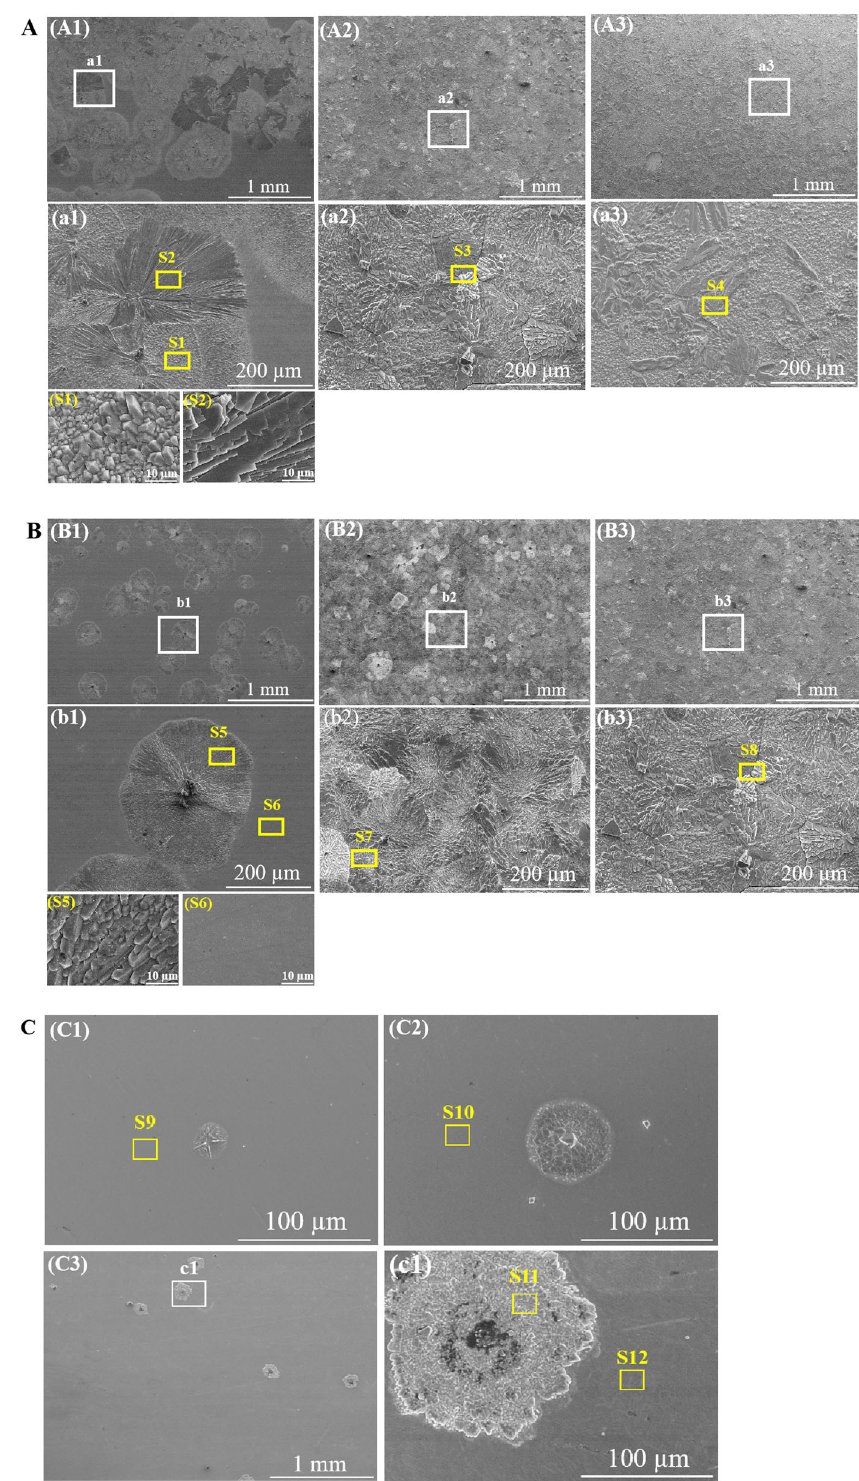
Fig. 3 SEM images of pure Zn after immersion in A PBS-0, B PBS-0.1 and (PBS-2) for (A1, B1, C1) 48 h, (A2, B2, C2) 168 h and (A3, B3, C3) 336 h; Yellow squares in S1-S10 indicate the area for EDS